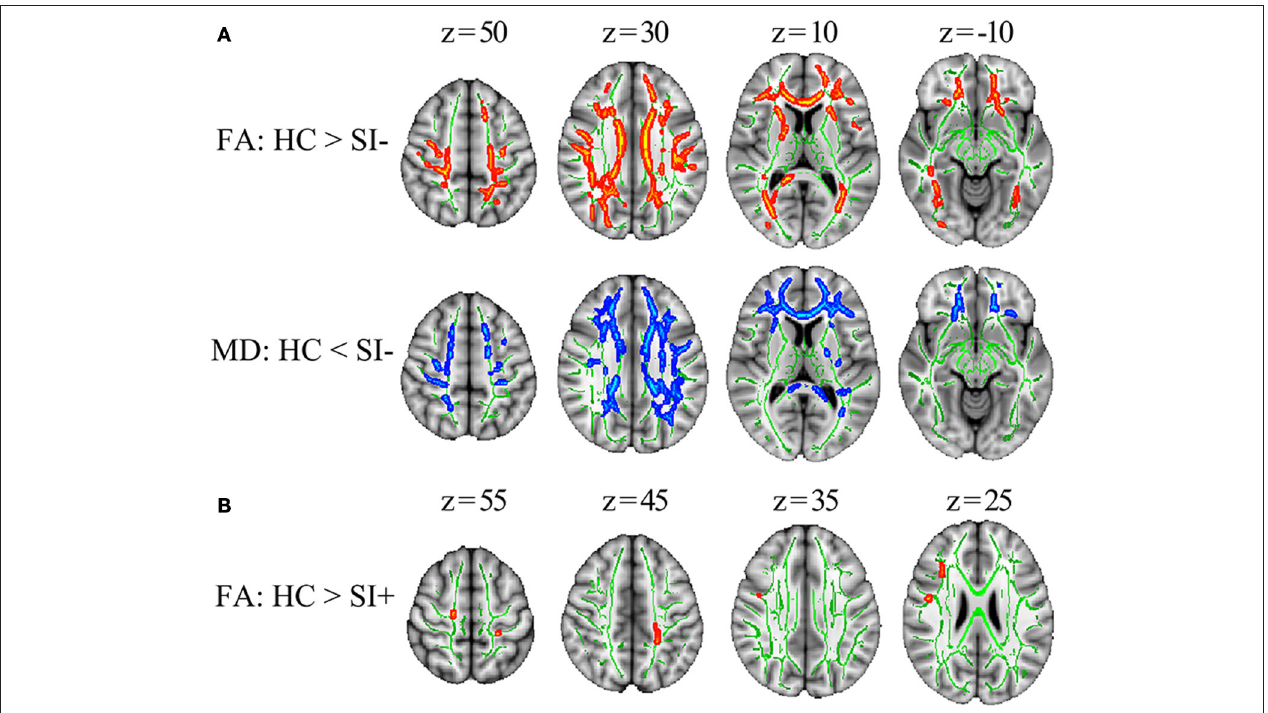
FIGURE 1 | The TBSS results comparing FES patients and healthy controls (HC). (A) The differences in FA and MD between the patients without suicidal ideation (SI–) and HC. (B) The differences in FA between the patients with suicidal ideation (SI + ) and HC. Significant areas ( p < 0.05, corrected) were marked in orange (higher in HC) or blue (lower in HC) with underlying WM skeleton marked in green. FA, fractional anisotropy; MD, mean diffusivity; x, y, z, MNI coordinates.